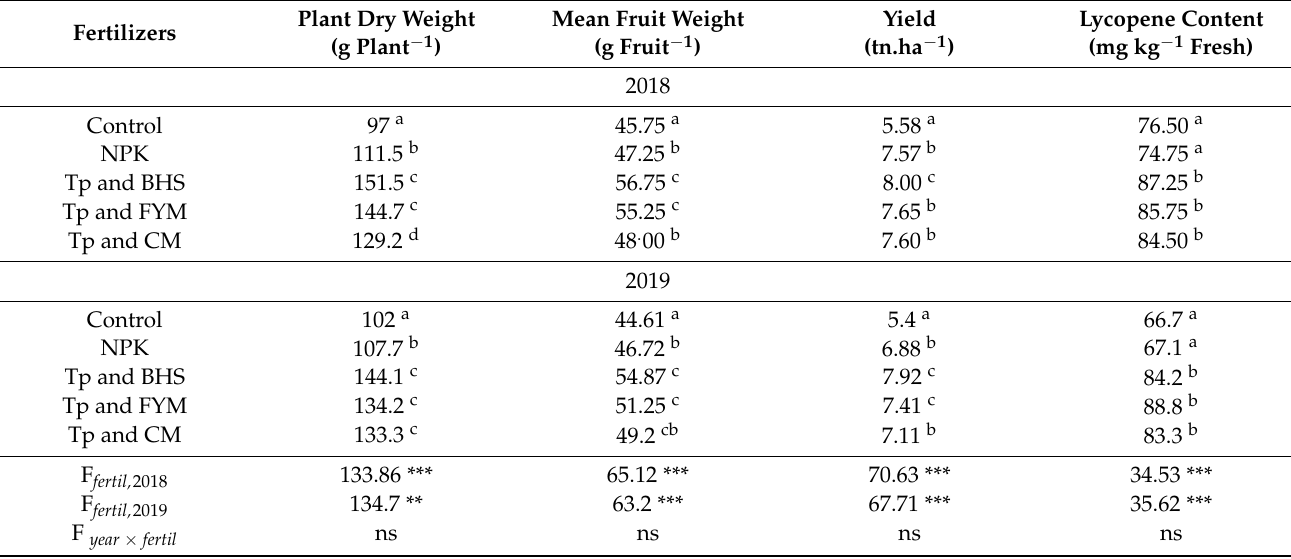
Table 3. Dry weight (g plant − 1 ), mean fruit weight (g fruit − 1 ), yield (tn.ha − 1 ), lycopene content (mg kg − 1 fresh) as effected by fertilizer treatments (control, NPK, Tp and BHS, Tp and FYM, and Tp and CM).